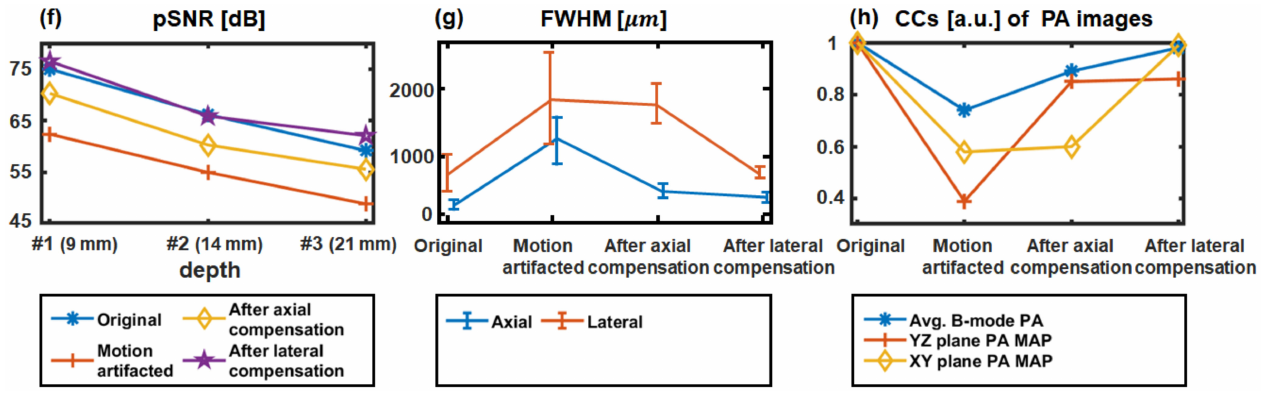
Figure 3. ( a ) Photograph of the 3D handheld scanner placed on the phantom and the phantom schematics. #1-#3 represent three black threads at different depths of 9, 14, and 21 mm, respectively. Yellow and green boxes represent signal and noise areas, respectively. ( b ) Original and ( c ) artificially motion-disrupted photoacoustic (PA) images: the average B-mode PA images along the Y axis, and the PA maximum amplitude projection (MAP) images along the YZ and XY planes, respectively. The average B-mode PA images and PA MAP images along the YZ and XY planes after ( d ) axial and ( e ) lateral motion correction. The X, Y, and Z directions represent lateral, elevational, and axial directions, respectively. The boxes are selected to calculate peak signal-to-noise ratios (pSNRs). ( f ) The pSNRs of the black threads at the different depths calculated at each step of process. ( g ) The FWHMs of the black thread at 9 mm depth calculated at each step of process. ( h ) The cross-correlations (CCs) between the original PA images and others. The original images are used as references to calculate CCs. TR: ultrasound transducer; FB: fiber